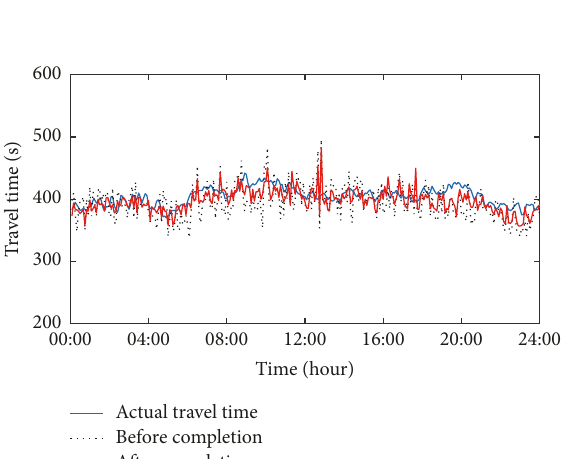
Figure 15: RE curves (03/02/2016).